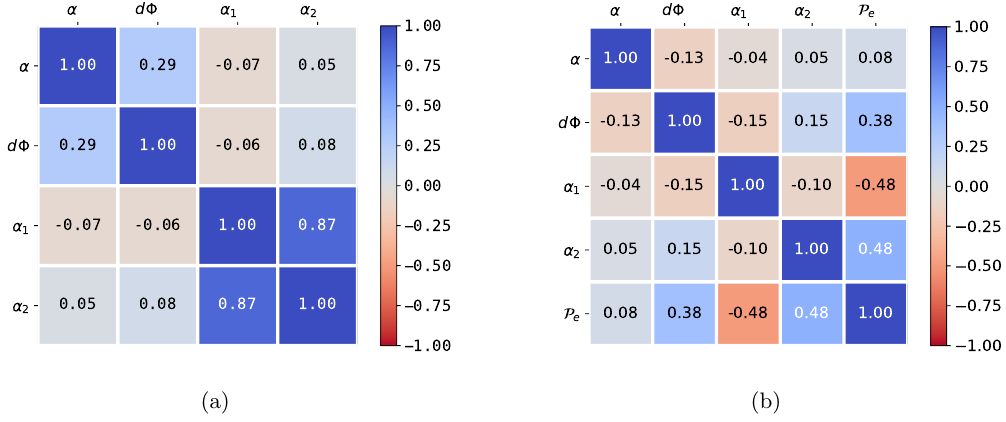
Figure 5 . Correlation matrices for the (cid:12)t schemes 1 (a) and 2 (b). Note the strong correlation of (cid:11) 1 and (cid:11) 2 in scheme 1 (unpolarized beam) and absence of this correlation in scheme 2 (electron beam polarization level of = 0 : P e